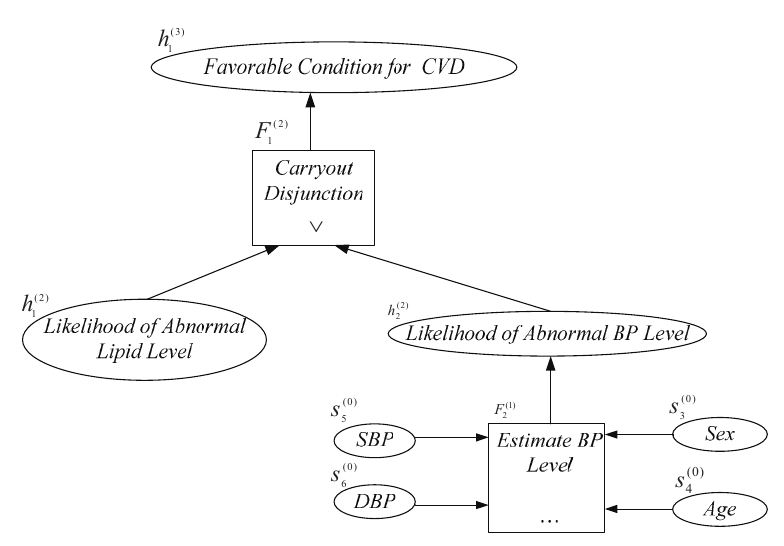
Figure 5. GBINM guides constructing branch 3 and linking it to